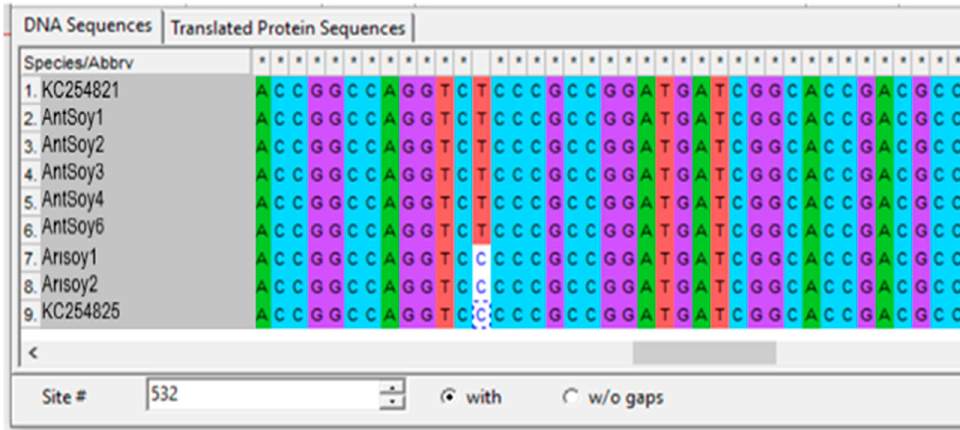
Figure 2. Mutation detected at point 532 that causes Pro197Ser alteration ( a ) The resistant mutant, AntSoy (TCC); ( b ) Wild-type, Arısoy (CCC).